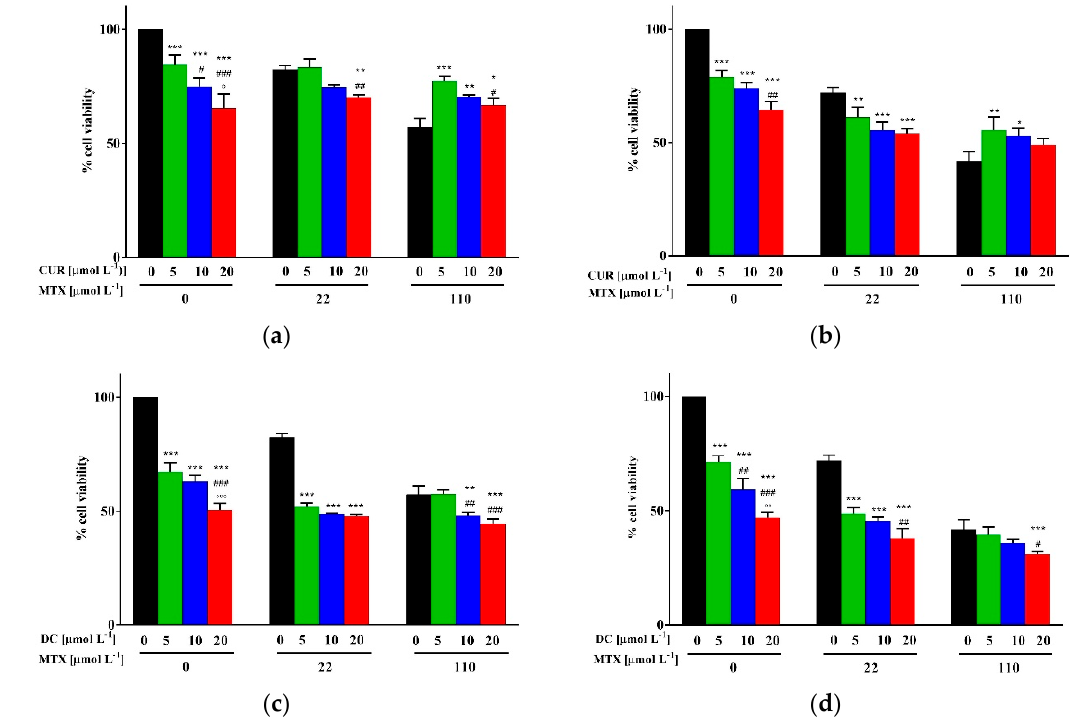
Figure 8. MCF-7 cells treated with different concentrations of ( a , b ) CUR and ( c , d ) DC in combination with MTX 22 and 110 µmol mL − 1 for ( a , c ) 24 or ( b , d ) 48 h. Within each MTX treatment, * p < 0.01, ** p < 0.001, *** p < 0.0001 vs. [CUR or DC] 0 µmol mL − 1 ; # p < 0.01, ## p < 0.001, ### p < 0.0001 vs. [CUR or DC] 5 µmol mL − 1 ; ° p < 0.01, °° p < 0.001, °°° p < 0.0001 vs. [CUR or DC] 10 µmol mL − 1 .